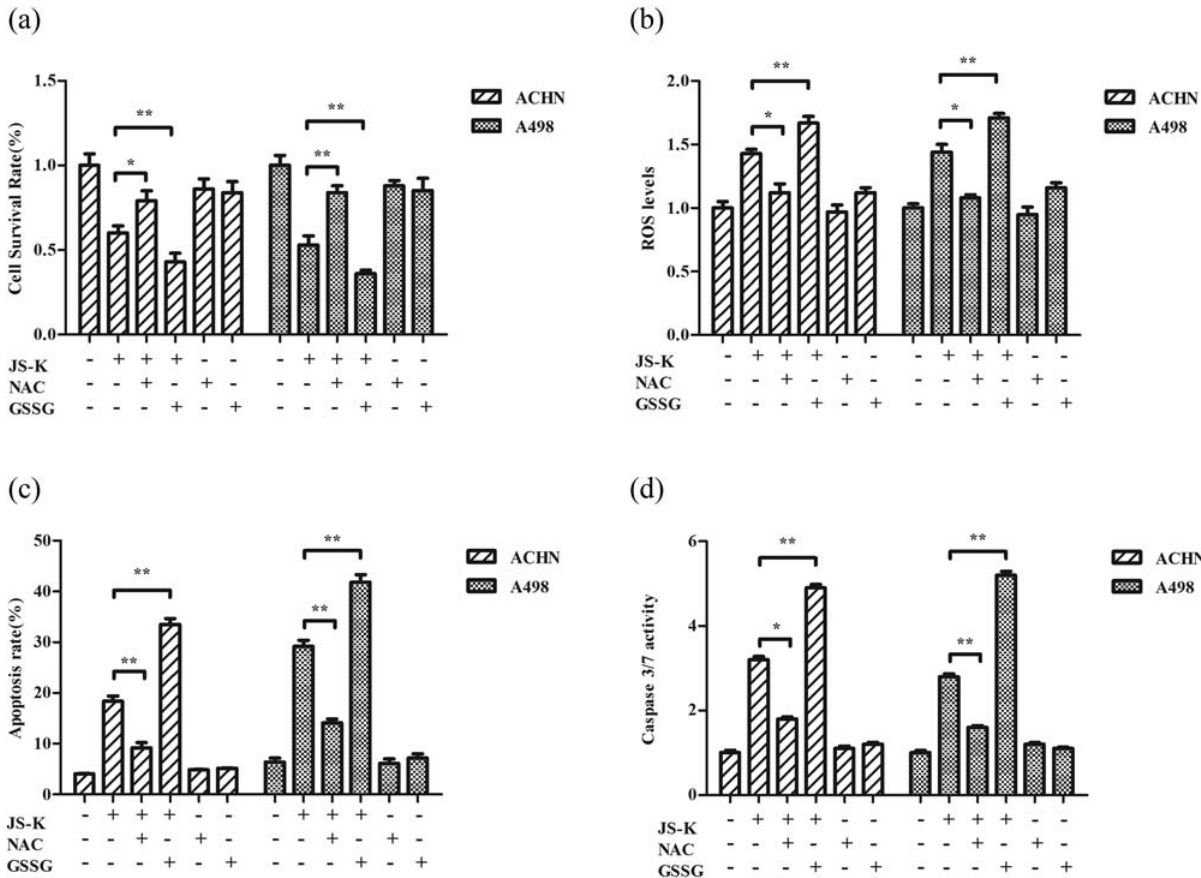
Figure 5: E ff ects of NAC and GSSG on JS - K - induced cell growth suppression and apoptosis. Cells were pre - cultured for 24 h with 100 μ M NAC or 5 μ M GSSG, and then incubated for 24 h both with and without 5 μ M JS - K. Cell survival was assessed by CCK - 8 assay ( a ) , and fl ow cytometry ( c ) was evaluated for cell apoptosis. Cells were pretreated with 100 μ M NAC or 5 μ M GSSG for 24 h and subsequently treated with or without 5 μ M JS - K for 6 h, and ROS output was measured ( b ) and Caspase - 3/7 activation was analyzed ( d ) . The values are represented as mean ± SD for at least three independent experiments. A single asterisk ( * ) shows a substantial di ff erence ( P < 0.05 ) , and a double asterisk ( ** ) ( P < 0.01 ) shows an exceedingly big variation.